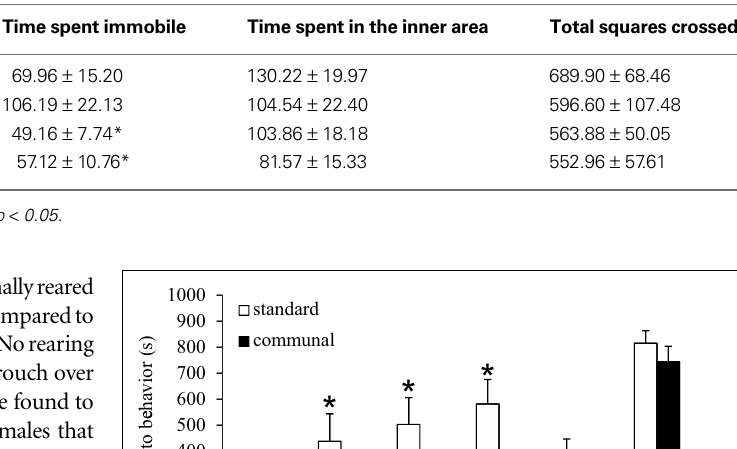
Table 2 | Open-fi eld behavior of F1 standard vs. communal reared offspring. Rearing condition Sex Number of boli